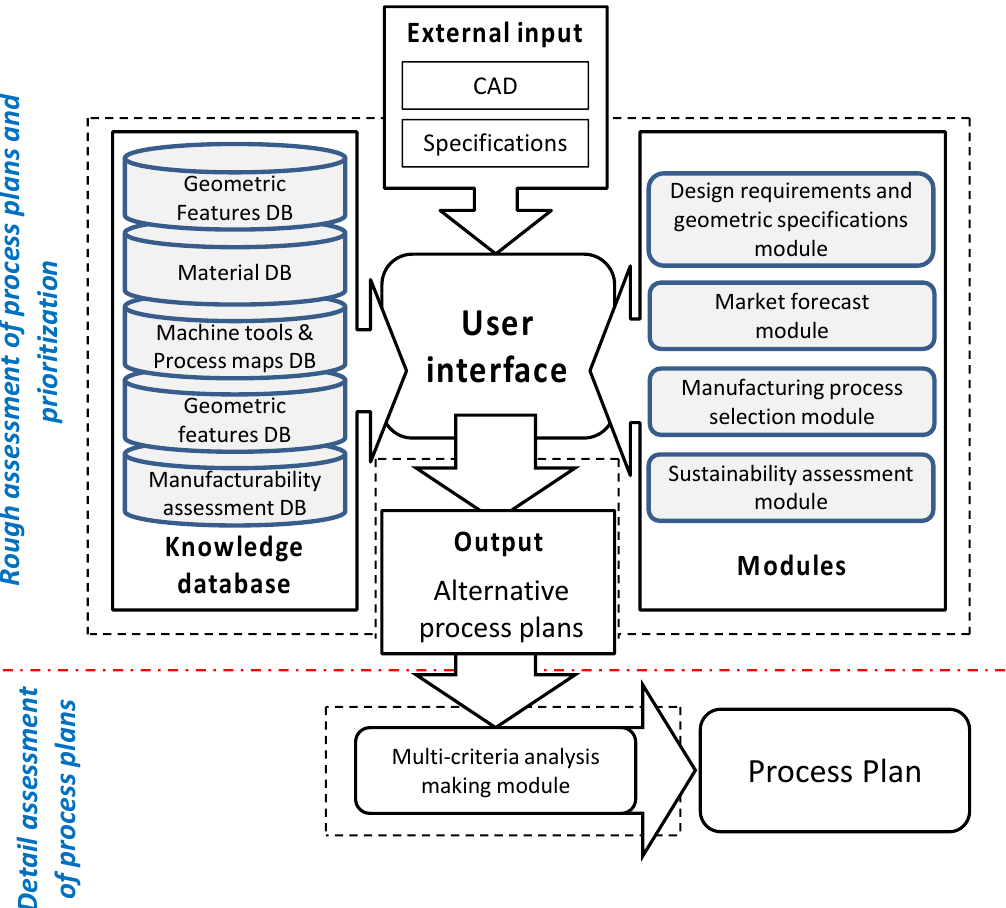
Figure 5. Block diagram of proposed method.